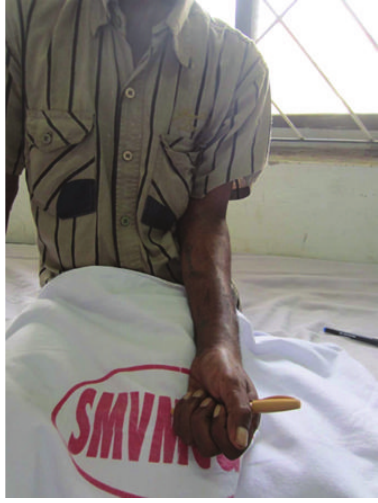
Figure 16: ROM (supination) at 1-year